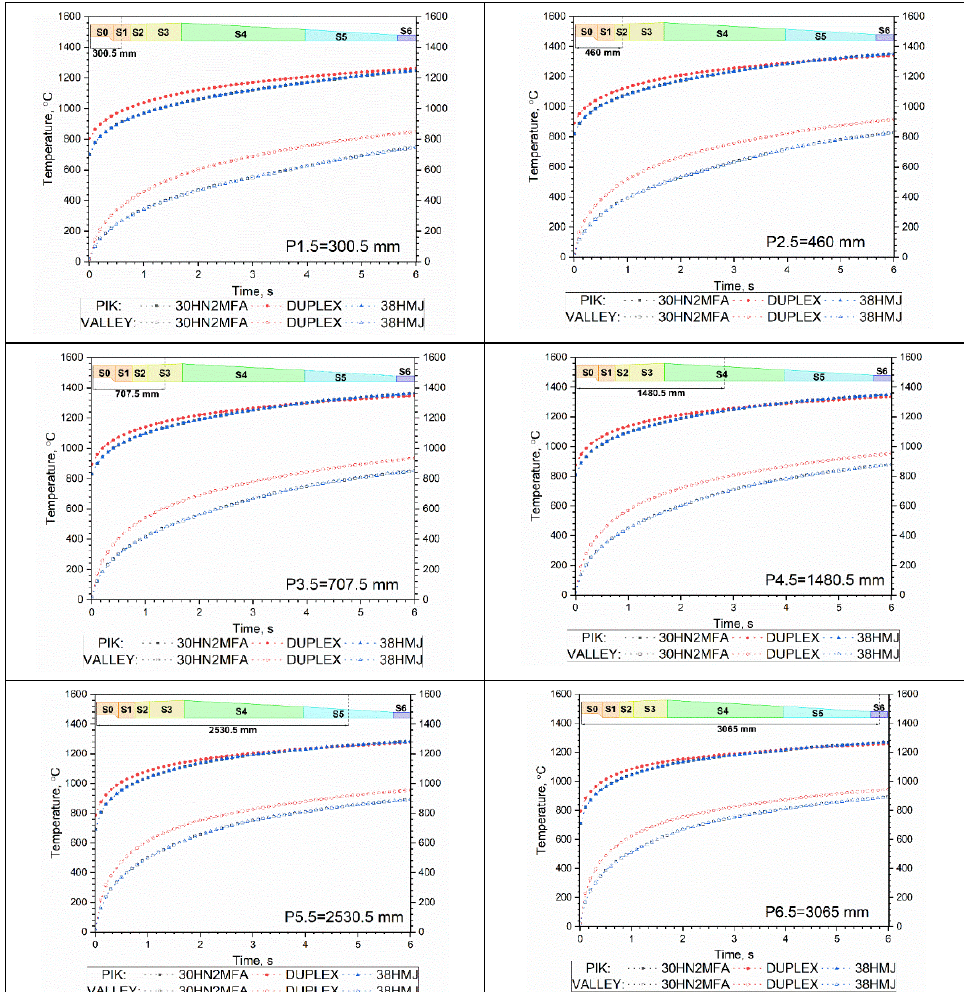
Figure 14 shows the envelopes of the so ‐ called highest peak temperatures and lowest peak base temperatures for 60 shots for all selected steels. For 38HMJ and 30HN2MFA steels, the lines match blue.